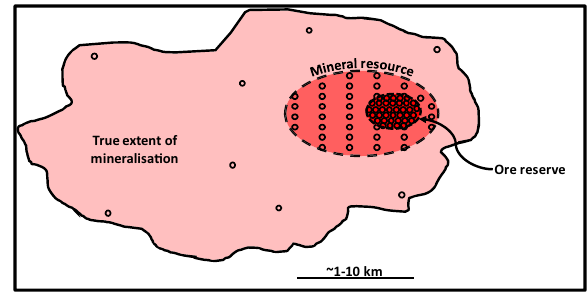
Fig. 1 Schematic diagram illustrating the relationship between ore reserves, mineral resources, and the true extent of mineralisation within a hypothetical mineral deposit system. Darker colours indicate increased geological con fi dence and probability of economic extraction. Circles indicate drillholes used for exploration and subsequent resource and reserve estimation, giving an indication of the con fi dence of the data used to delineate different parts of the mineralised system. Note that resources and reserves only make up a small part of the true extent of mineralisation; the latter may well be known as a result of fi eld mapping, geological and geochemical sampling, geophysical imaging, and some drilling, but cannot be reported because the geological con fi dence in the continuity of the mineralisation and associated economic prospects may not be suf fi cient to meet the criteria needed for resource or reserve reporting. Exploitation of known reserves would be followed by conversion of resources to reserves and the delineation of more resources from the surrounding poorly delineated mineralisation, extending the initially stated life of mine and causing resources and reserves to remain static or potentially grow coincident with production. There are many examples of the above — such as Olympic Dam, Antamina, Ertsberg-Grasberg, Escondida, Kalgoorlie, Highland Valley, and the Sudbury Basin, amongst many others 20